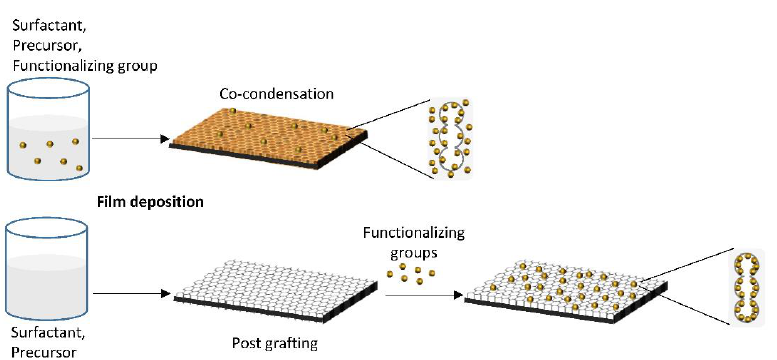
Figure 2. Schematic representation of mesoporous thin film functionalization. Post grafting ( bot- tom ) promotes the accessibility of more functional groups, with respect to co-condensation ( top ) where they are dispersed through the whole mesoporous matrix instead of the pores surface only.